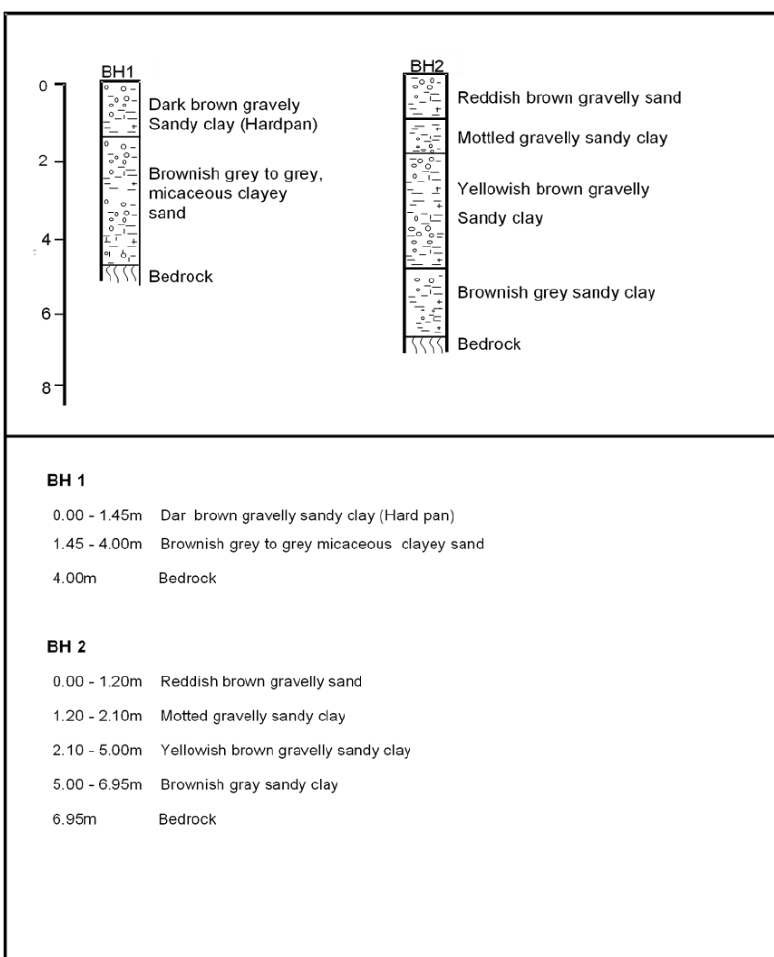
Figure 3: Lithological Section of the Bridge Site. Source: Authors,